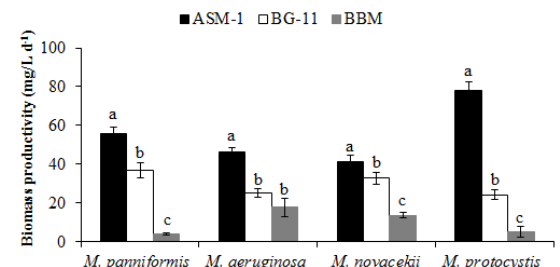
Figure 3 - Mean biomass productivity and standard deviations (mg/L d -1 ) of cyanobacteria species cultivated in distinct culture media for 13 days. *Significant differences among the culture media are indicated by different letters (ANOVA One- Way with post hoc Tukey’s LSD,